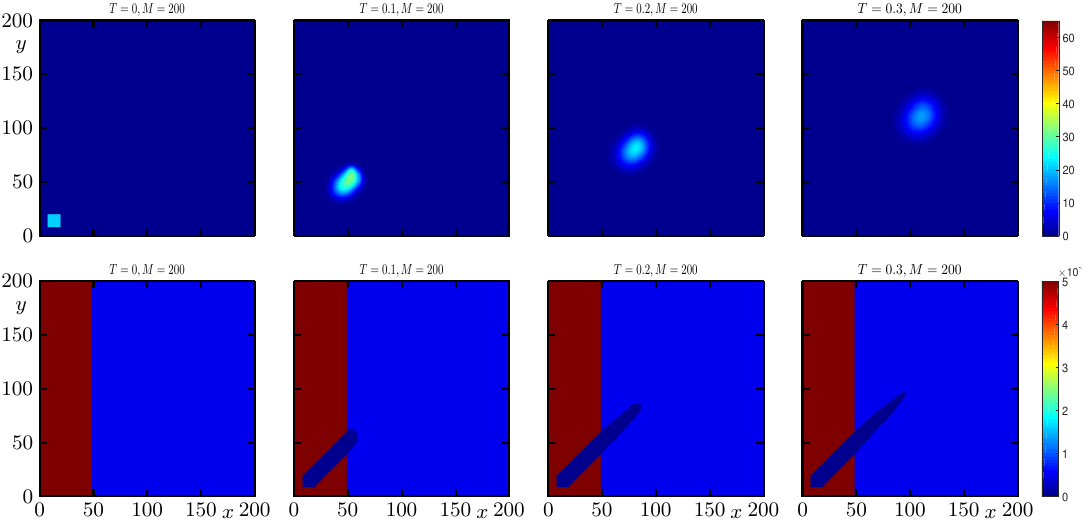
Figure 5. Example 2: Evolution of the dynamics of temperature ( top ) and fuel ( bottom ). Simulation when the wildfire enters a region with a very low fuel